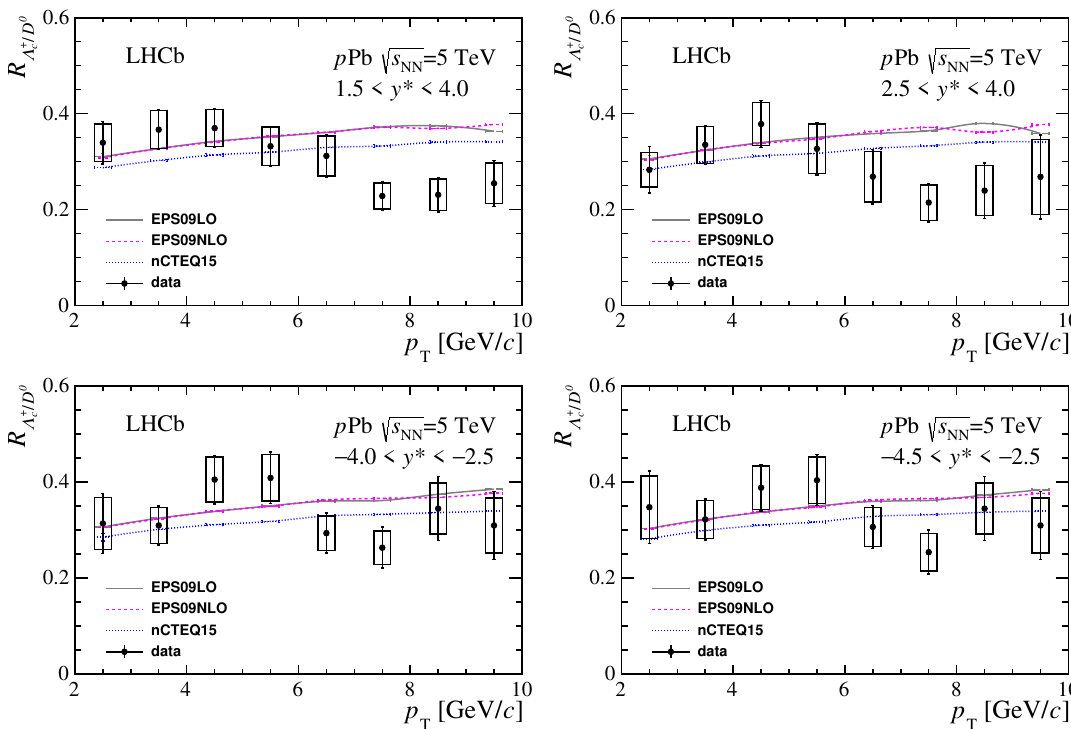
Figure 6 . The cross-section ratio R between (cid:3) + baryons and D 0 mesons as a function of c (cid:3) + c =D 0 p T integrated over four di(cid:11)erent rapidity regions. The box on each point represents the systematic uncertainty and the error bar represents the sum in quadrature of the statistical and the systematic uncertainties. The coloured curves represent HELAC-Onia calculations with nPDF EPS09LO/NLO and